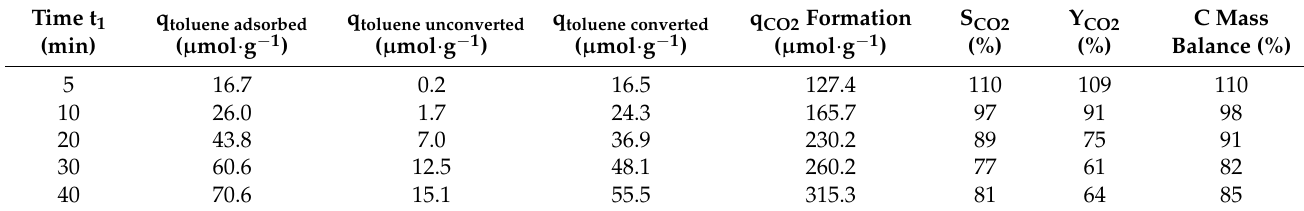
Table 1. Performances of the APC process as a function of storage time span t 1 .